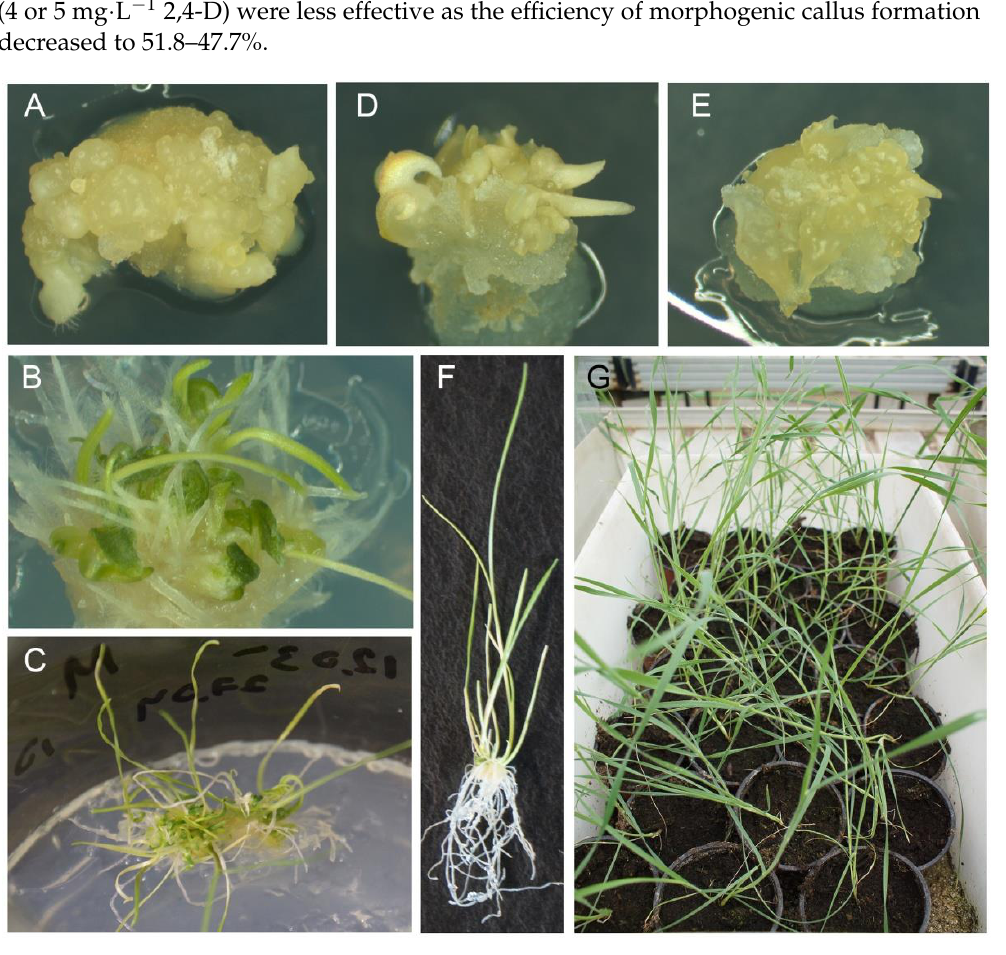
Figure 1. Plant regeneration process in immature embryo-derived culture of Triticum urartu , spring accession PI428197 . The appearance of embryogenic calli with somatic embryos on the medium supplemented with 2 mg·L −1 2,4-D ( A ) after 30 days of culture in the dark; the regenerable calli with green buds and leafy structures on the phytohormone-free medium ( B ), after 10 days of culture in the light; formation of plantlets from regenerable calli ( C ), after 20 days in the light; embryogenic callus formation from immature embryo after induction with 4 mg·L −1 Dicamba ( D ) and 4 mg·L −1 Picloram ( E ) after 30 days of culture in the dark; healthy plantlets with roots before being transferred to greenhouse ( F ); regenerated plants grown under greenhouse conditions ( G ).